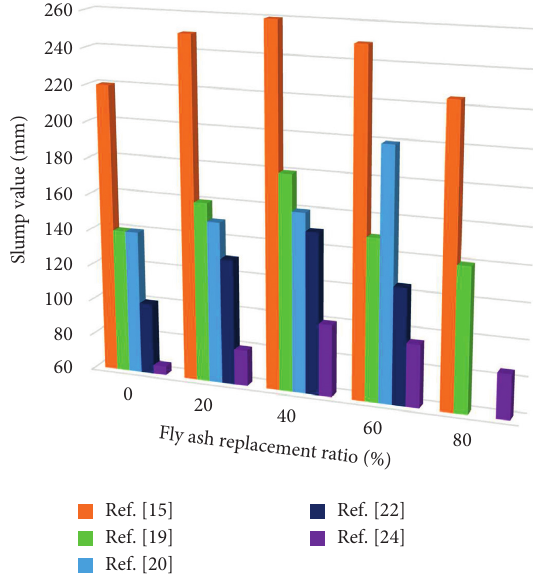
Figure 2: Slump value of FA-based cementitious composites as a function of the fly ash replacement ratio, based on data collected from relevant